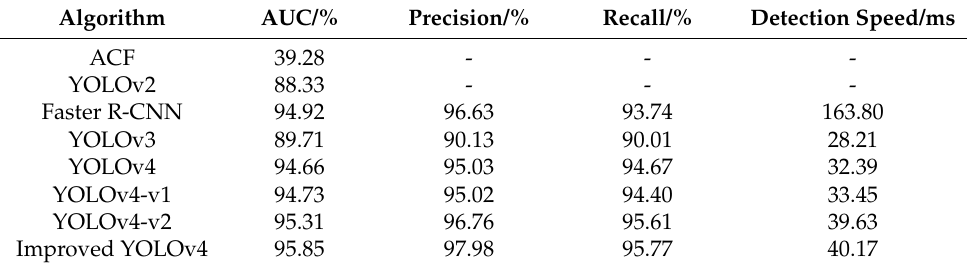
Figure 10. Comparison of the detection results using multiple algorithms for traffic lights in different scenarios in the LaRa data set. ( a ) Faster R-CNN. ( b ) YOLOv3. ( c ) YOLOv4. ( d ) YOLOv4-v1. ( e ) YOLOv4-v2. ( f ) Improved YOLOv4. Table 7. Traffic light detection performance index in the LaRa data